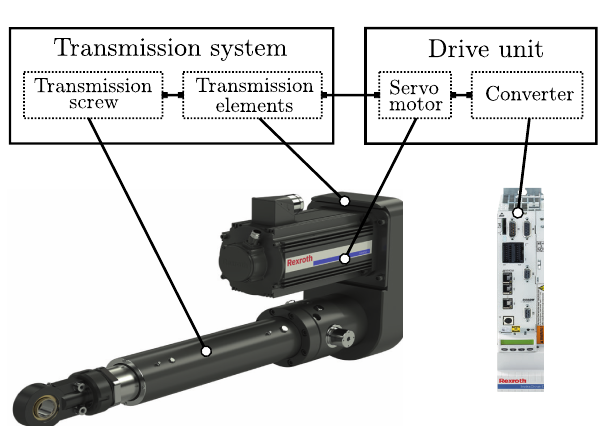
Figure 6: Bosch Rexroth EMC-HD drivetrain with mo- tor attachment via timing belt side drive.